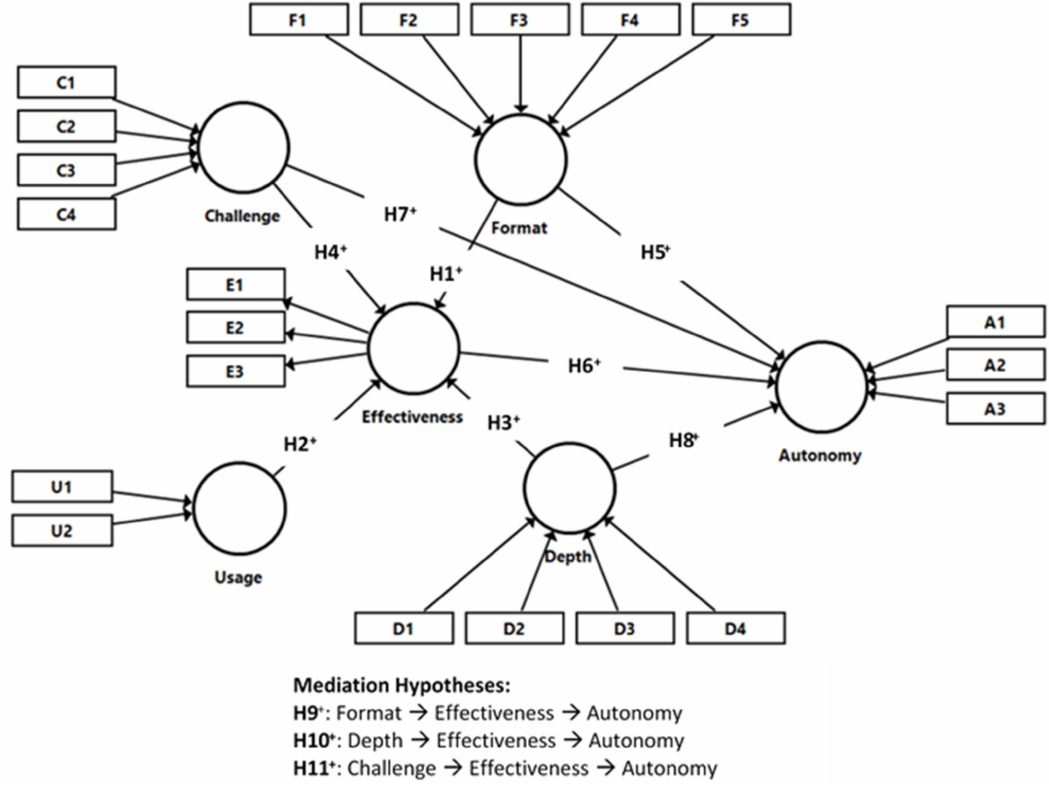
Figure 1. Research model and hypotheses. C: Challenge, U: Usage, E: Effectiveness, F: Format, D: Depth, A: